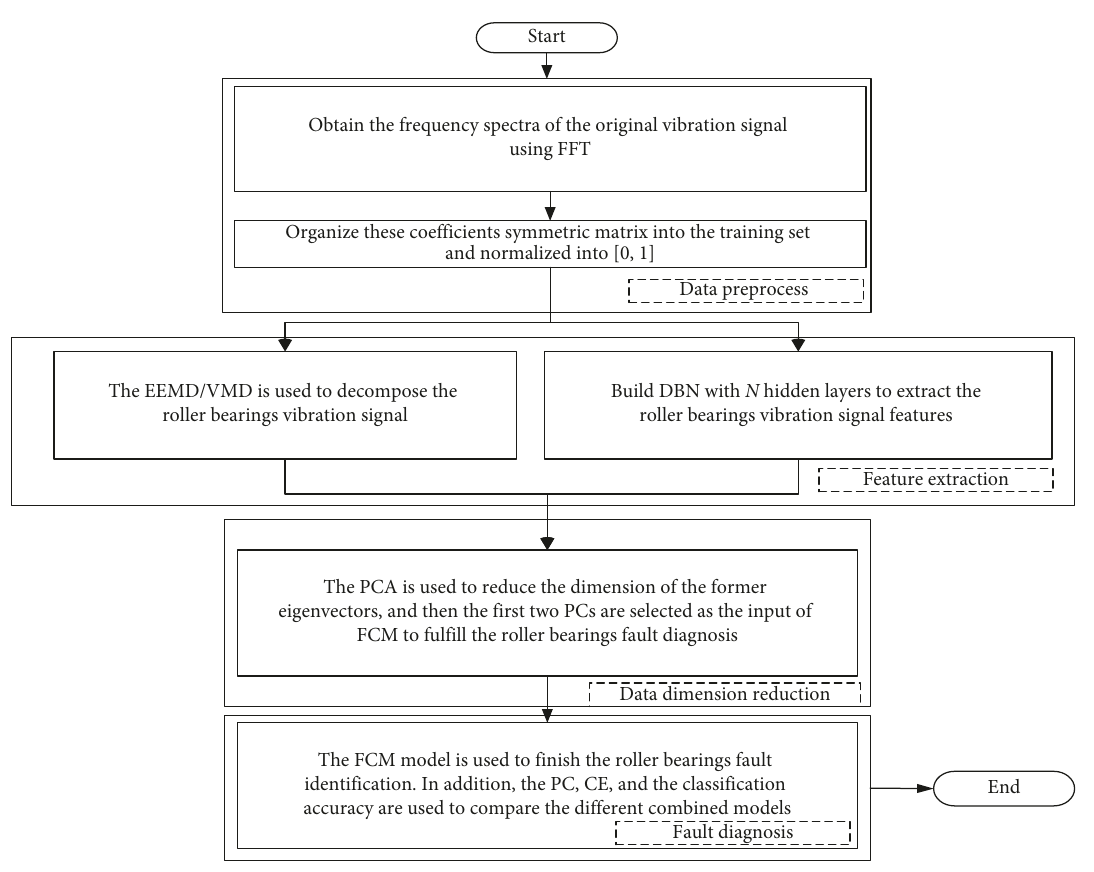
Figure 3: The flow chart of the method